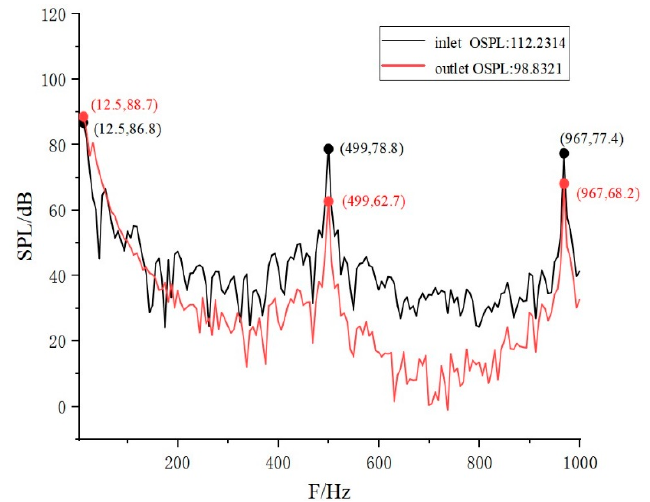
Figure 14. Sound pressure level curve at 120° angle.